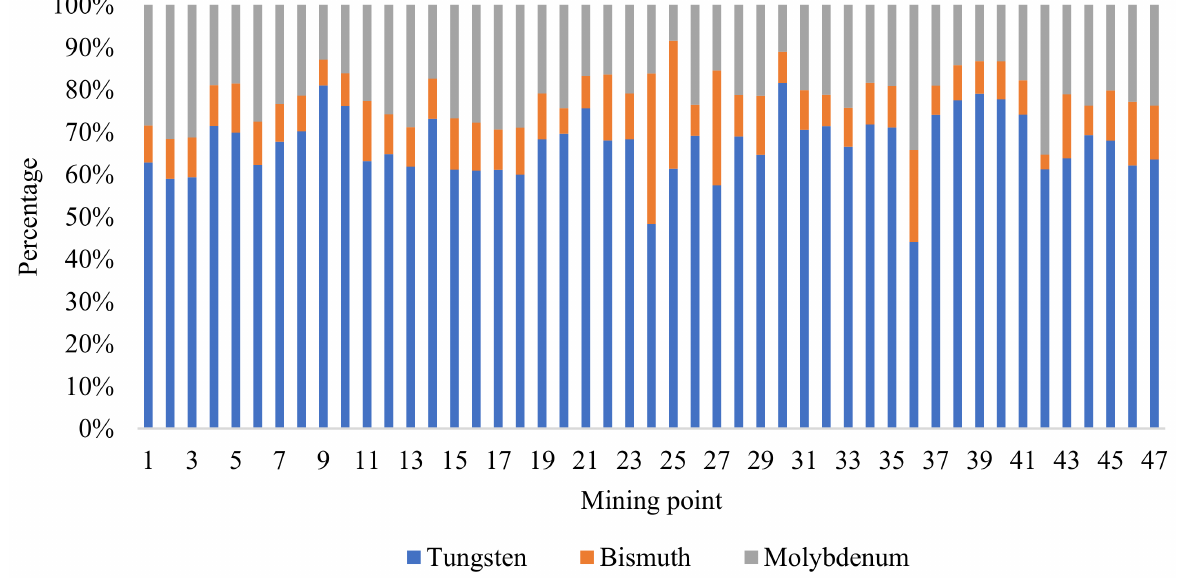
Figure 4. The proportion of tungsten, bismuth, and molybdenum at each mining